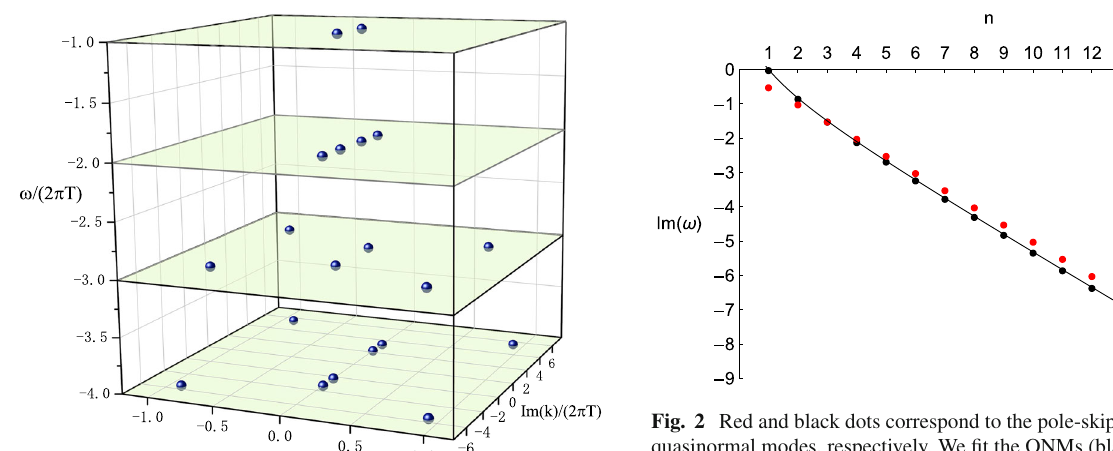
three order pole-skipping points are shown in Fig. 1, where we have chosen r 0 = 1, α = 1, and c s = 1 /